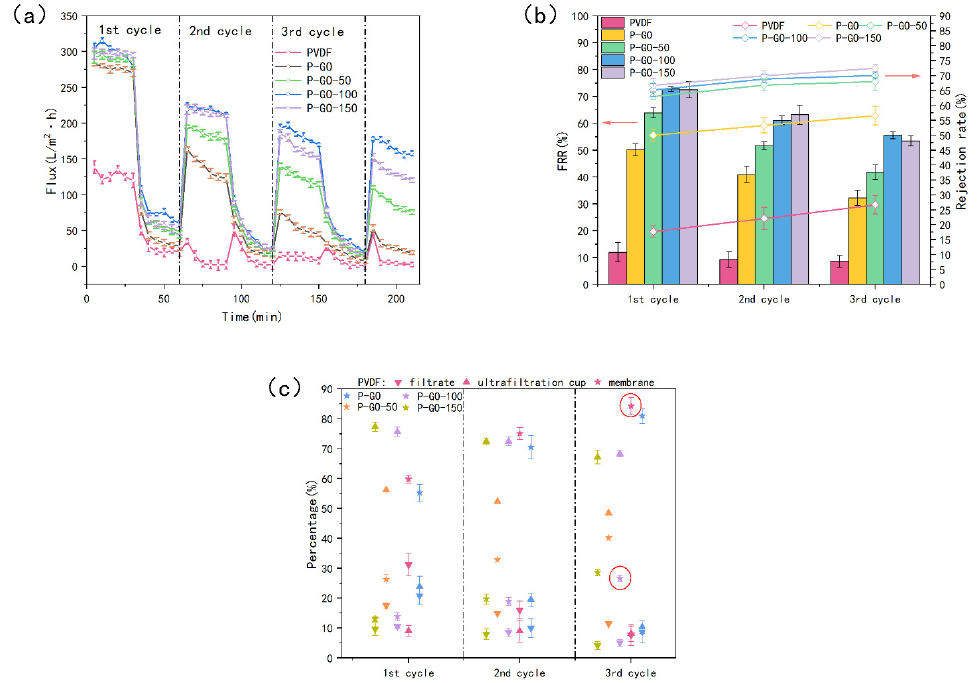
Figure 12. The results of three cycles ultrafiltration experiment. ( a ) The membrane flux change; ( b ) flux recovery rate and rejection rate of membranes; ( c ) the bacterial distribution in the test.